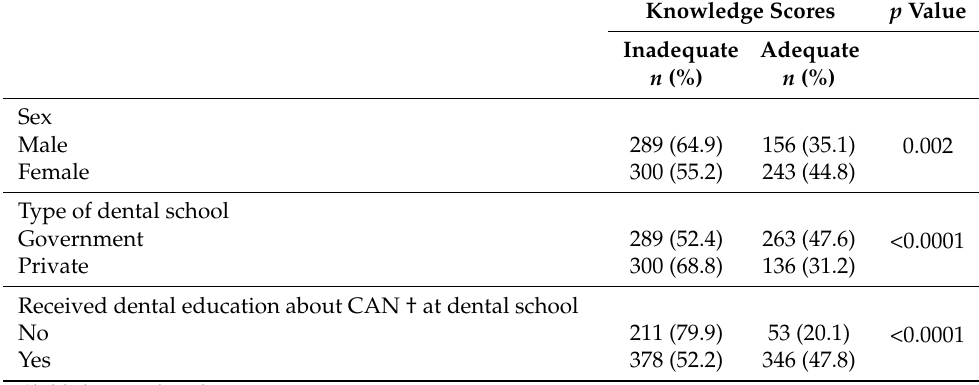
Table 2. Participants’ knowledge scores in association with key variables of the study sample ( n = 988).